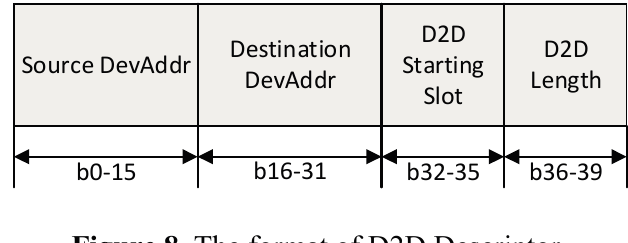
Figure 8. The format of D2D Descriptor.